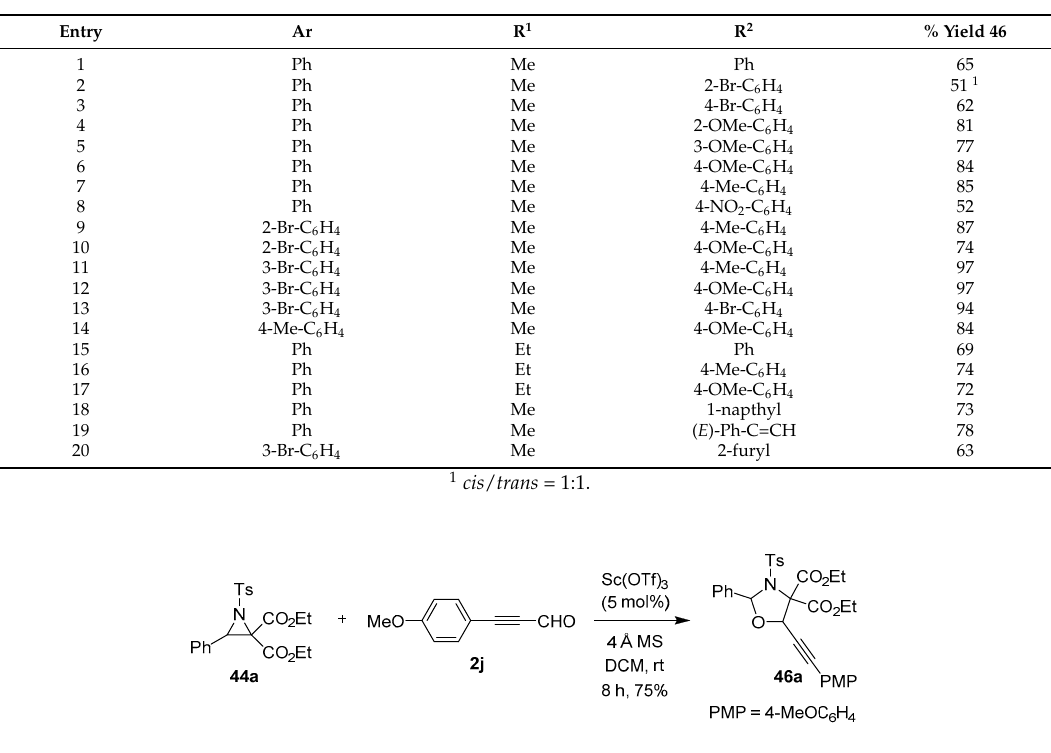
Table 6. Zinc triflate-catalyzed cycloaddition of azomethine ylide 45 to aldehydes 2 (Scheme